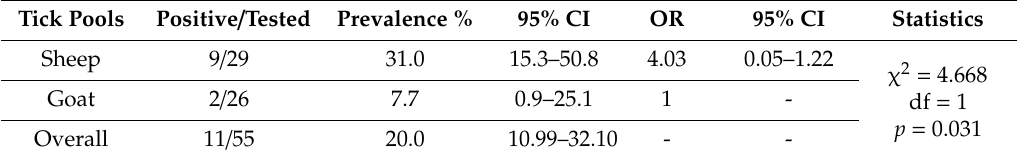
Table 4. Prevalence of C. burnetii DNA in 55 pools of ticks collected from small ruminants. Tick